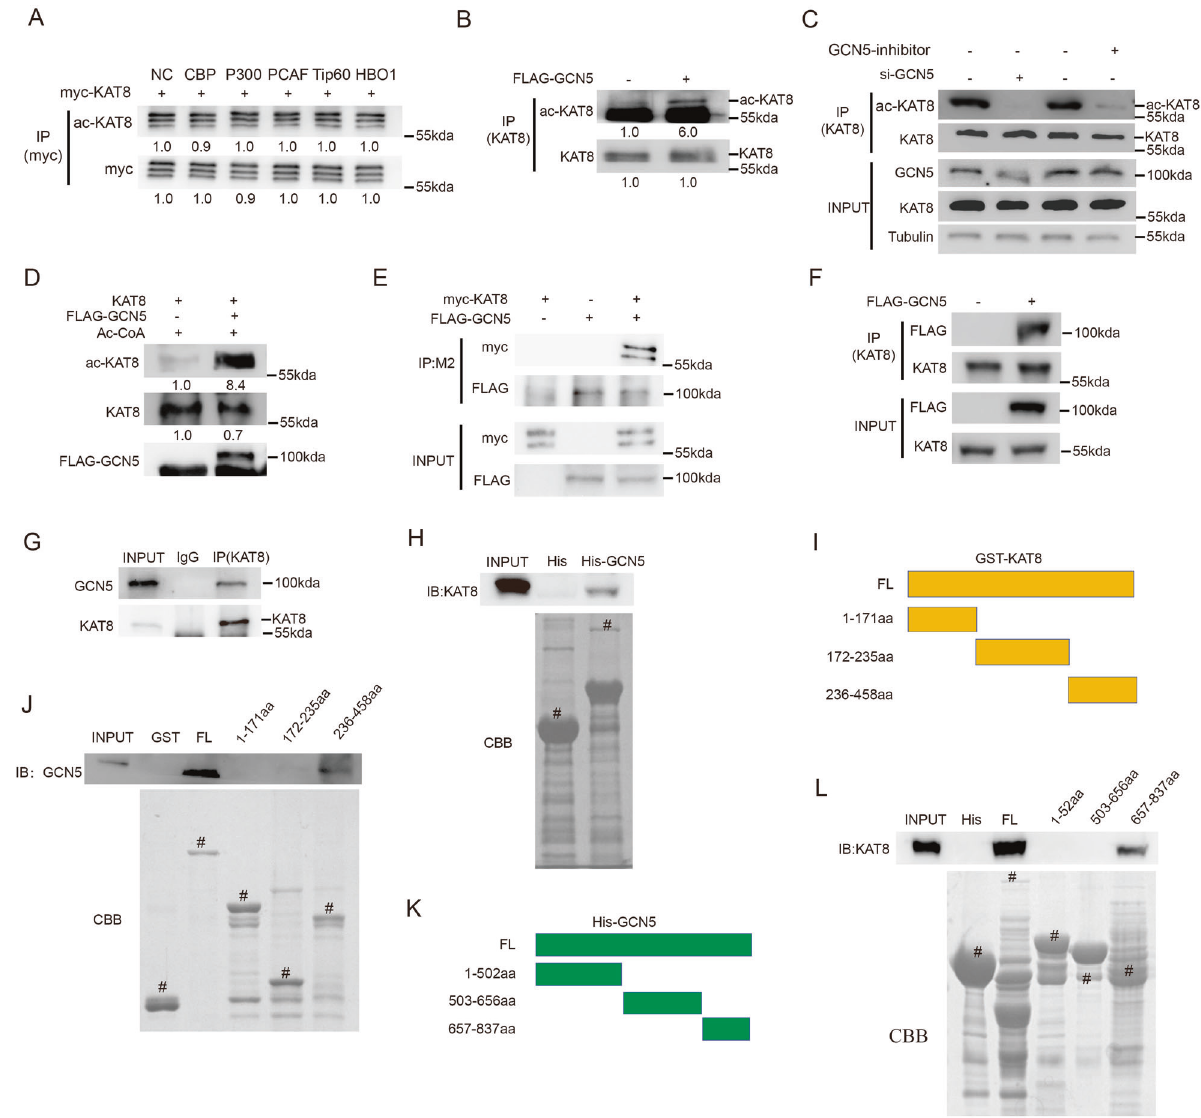
Fig. 2 GCN5 is an acetyltransferase of KAT8. A , B KAT8 was co-transfected with several critical acetyltransferases in HCT116 cells and then Co-IP was performed to detect the level of KAT8 acetylation. C HCT116 cells were transfected with GCN5 siRNA or treated with GCN5 inhibitor MB-3, and then Co-IP was performed to detect the level of KAT8 acetylation. D Flag-GCN5 was transfected into HCT116 cells and then KAT8 and Flag-GCN5 proteins were puri fi ed to perform in vitro acetylation assay. The level of KAT8 acetylation was detected by Western blotting. E HCT116 cells were co-transfected with Flag-GCN5 and myc-KAT8 and then proteins were extracted for Co-IP to detect the exogenous interaction between KAT8 and GCN5. F HCT116 cells were transfected with Flag-GCN5 and then proteins were extracted for Co-IP to detect the semi-exogenous interaction between KAT8 and GCN5. G Protein of HCT116 cells was extracted for Co-IP to detect the endogenous interaction between KAT8 and GCN5. H His-GCN5, GST-KAT8 and GST were expressed, and puri fi ed in bacteria. GST-pull down assays were performed to show the direct interaction between GCN5 and KAT8 in vitro. I Schematic of plasmids encoding KAT8. J GST-KAT8 FL or fragments were incubated with His-GCN5, and Western blotting or Coomassie staining was performed to detect the direct binding of KAT8 and GCN5 in vitro. K Schematic of plasmids encoding GCN5. L His-GCN5 FL or fragments were incubated with GST-KAT8, and Western blotting or Coomassie staining was performed to detect the direct binding of GCN5 and KAT8 in vitro. # indicates the speci fi c bands. same time, the glycerol releases in KAT8-2KR overexpression at lysine 168 and lysine 175 residues after PA treatment (Fig. 5A). HCT116, RKO and SW480 cells were signi fi cantly increased These two sites are highly conserved from EQUUS to humans comparing with KAT8 WT transfected cells (Fig. 5E – G). These data (Fig. 5B). To further con fi rm the acetylation sites of KAT8, lysine to demonstrate that K168 and K175 are two major functional sites of alanine mutant KAT8-K168R, KAT8-K175R or KAT8-2KR plasmids KAT8 acetylation and involve in mediating lipolysis of CRC cells. were generated and transfected into HCT116 cells. As shown in Fig. 5C, KAT8 acetylation was reduced signi fi cantly after PA KAT8 regulates the expression of lipolysis-related genes via its stimulation in both mutated KAT8 transfected cells. Also, the acetylation results of co-transfected with Flag SIRT6 plasmids showed that the Having known that KAT8 acetylation has the ability to regulate reduction of KAT8 acetylation in KAT8 WT transfected cells was lipolysis of CRC cells, we next explored the mechanism under this completely recovered in KAT8 KR transfected cells (Fig. 5D). At the